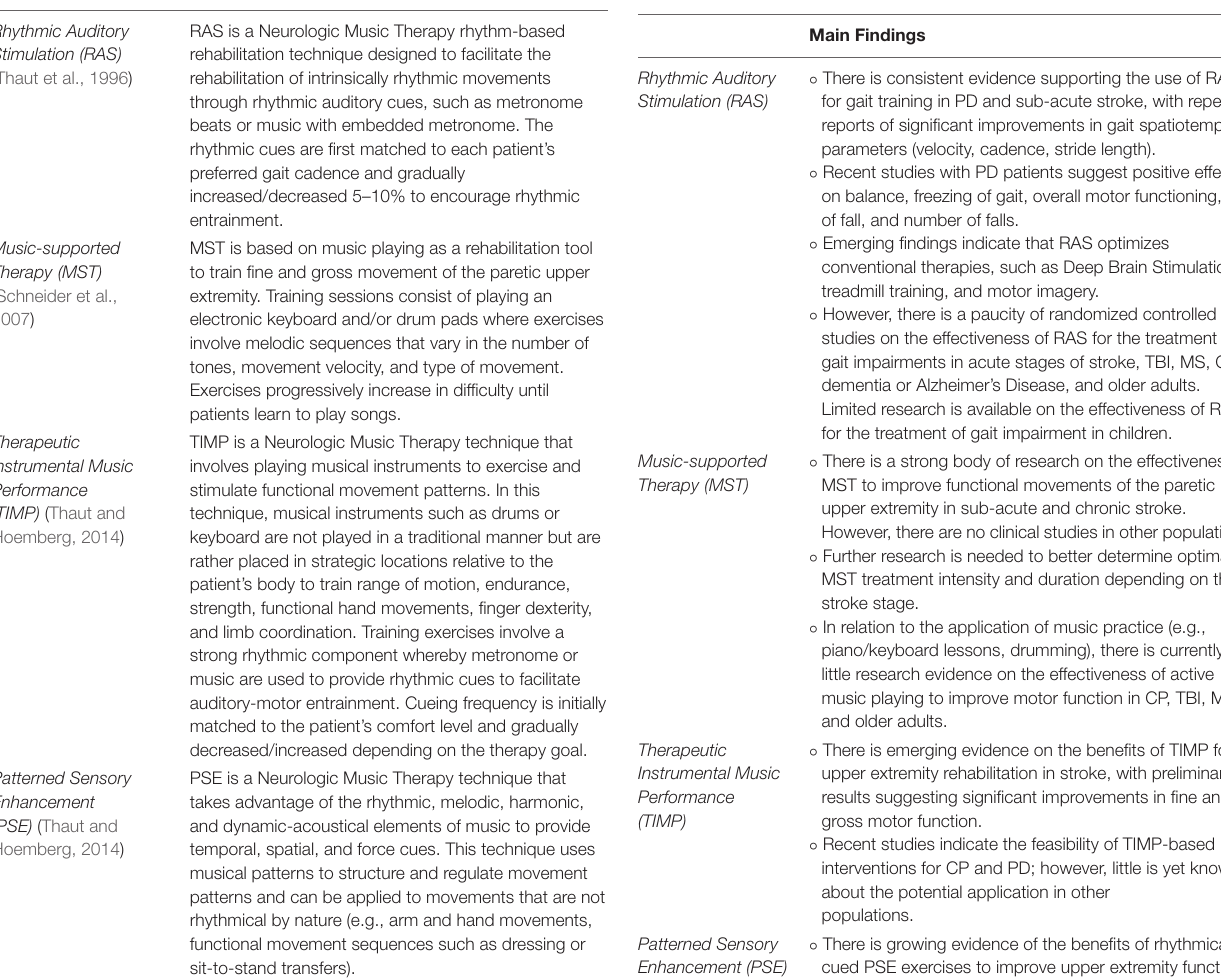
TABLE 1 | Description of interventions. TABLE 2 | Current state of knowledge: summary of current findings on the therapeutic effects of rhythm- and music-based interventions (RAS, MST, TIMP, and PSE) on motor